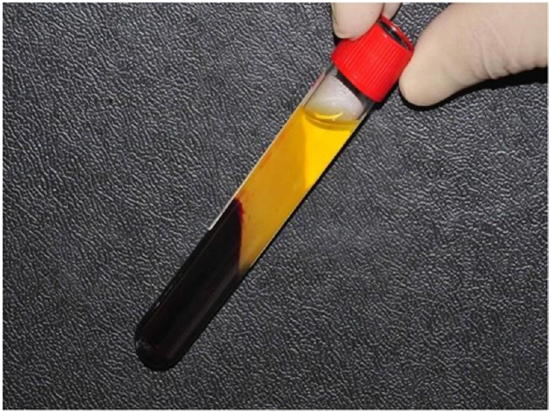
Figure 1. Vacuum tube after centrifugation (3 layers visible—the middle is the PRF).